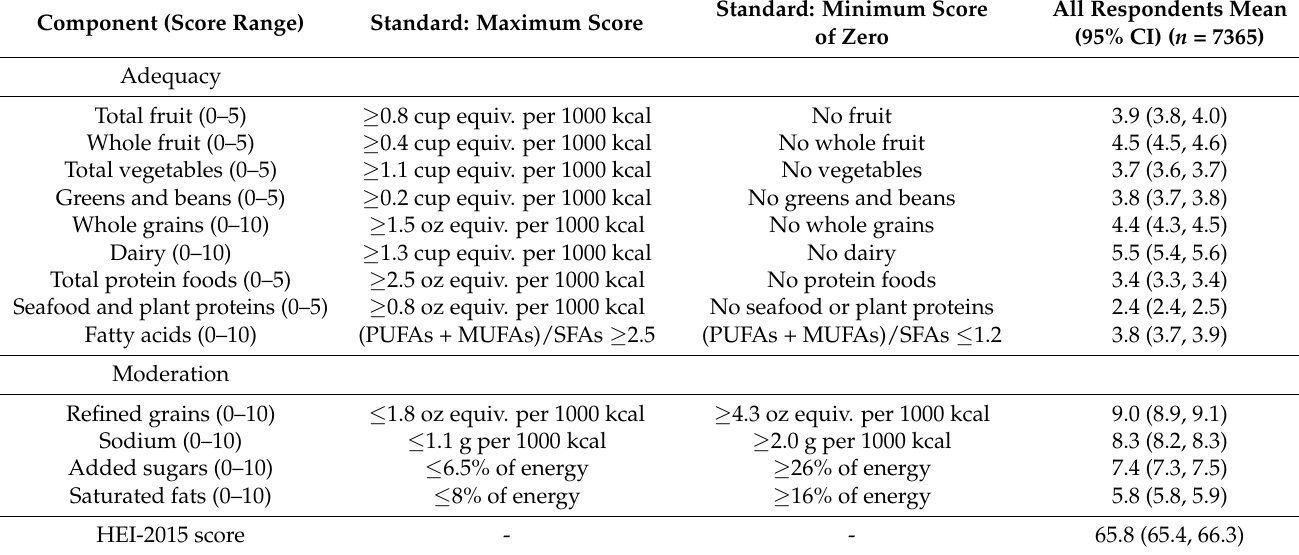
Table 1. Healthy Eating Index (HEI)–2015 and component